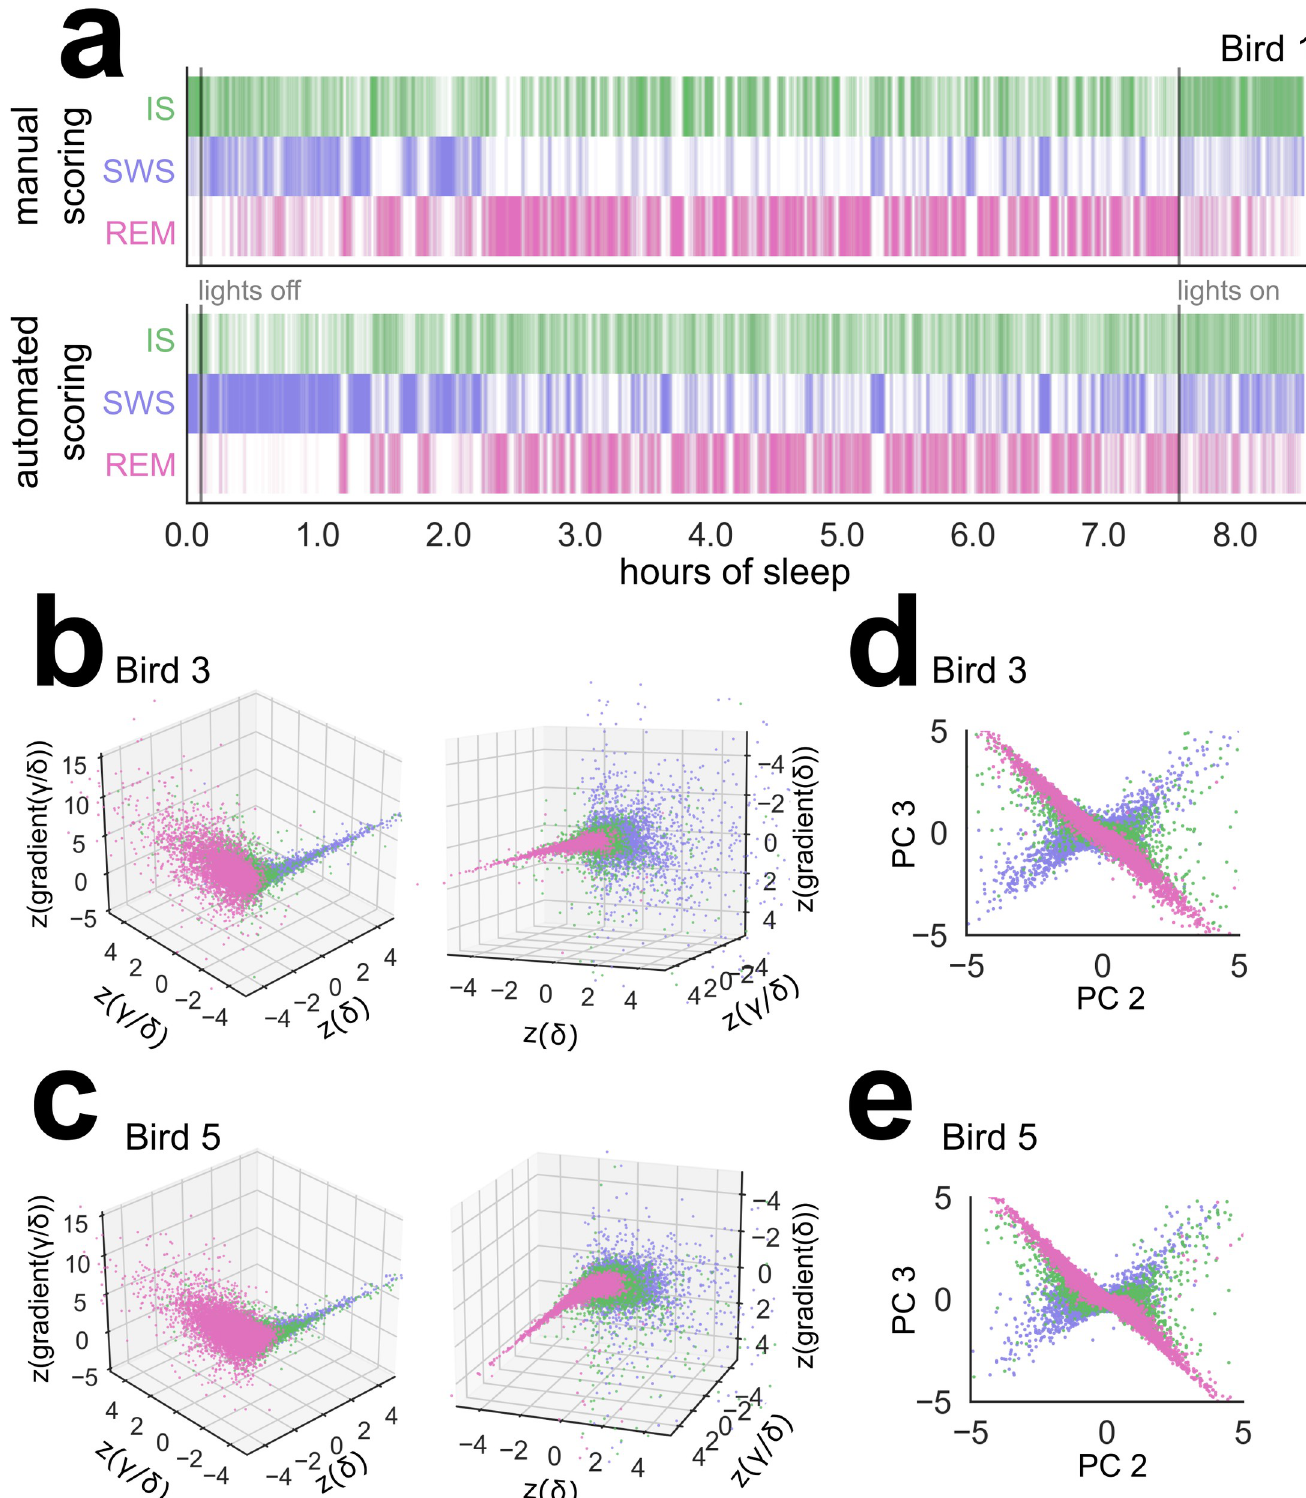
Fig 8. Automated sleep scoring. (a) Example hypnogram comparing manual scoring (top) to automated scoring (bottom). Each tick represents one 3-s epoch. There is general concordance between the two (see text). In this example the automated scoring finds somewhat more SWS and less IS and REM. (b) Spectral